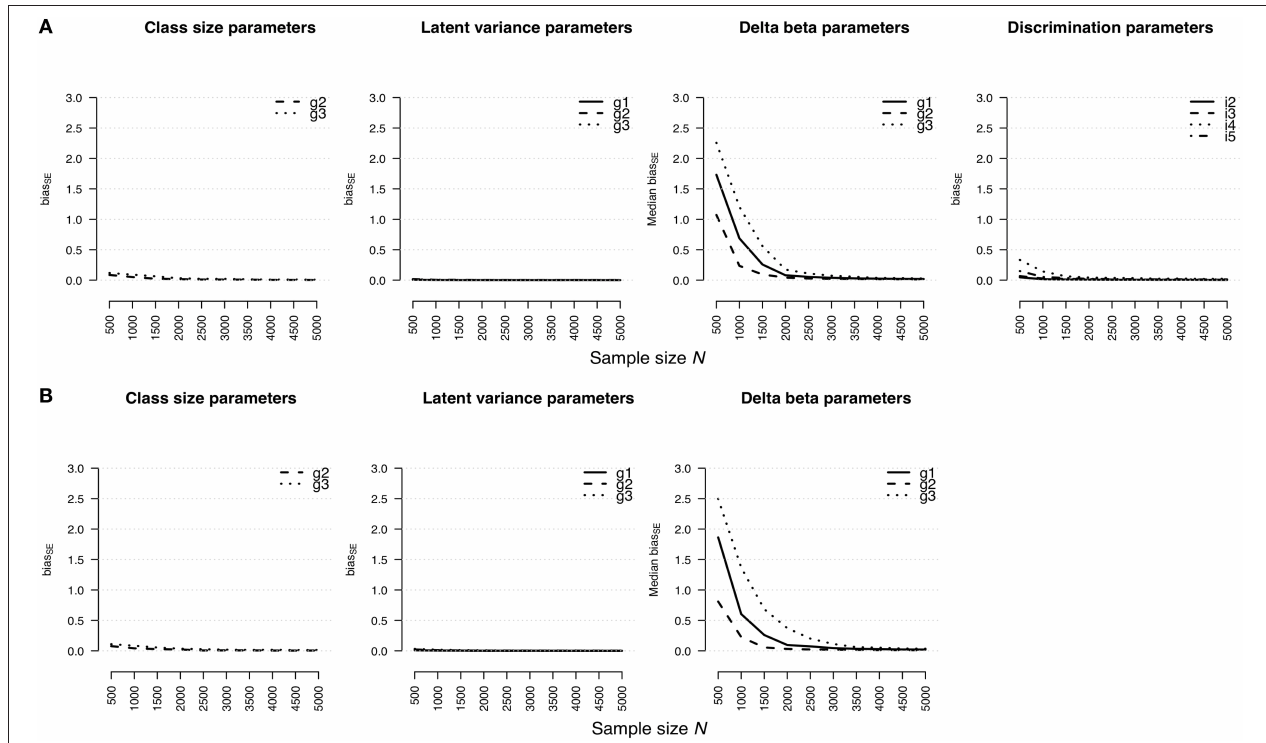
FIGURE 2 | Bias of standard error estimates for parameter estimates in (A) the rmGPCM-3 and (B) the mPCM-3 under the condition of a three-class mixture and a 5-item scale with 11 categories.